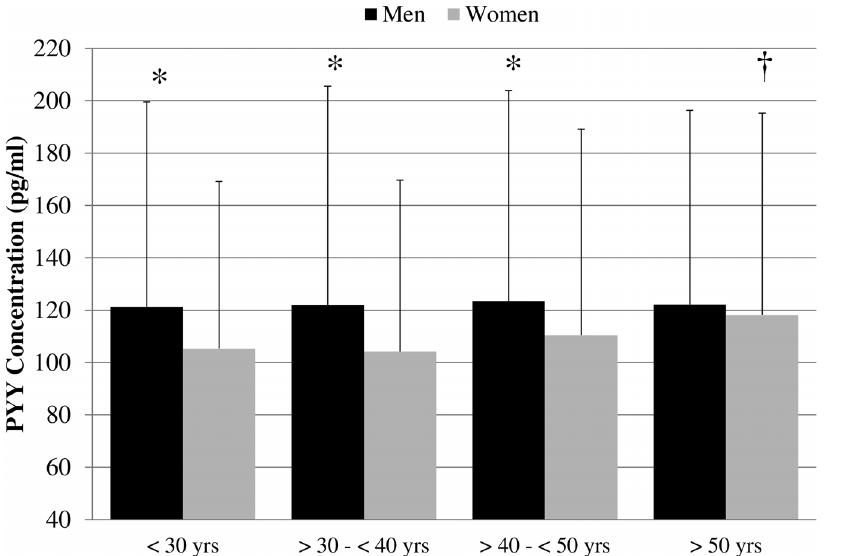
Figure 2. Fasting Serum PYY for men and women in four age groups. Fasting PYY concentration was 15.2%, 17.1% and 11.8% greater among men than women within the , 30 yrs, . 30– , 40 yrs, and . 40– , 50 yrs groups respectively (*). Additionally, the $ 50 yrs group of women had a 12.2% higher circulating level of PYY than women in the , 30 yrs group ( { ). doi:10.1371/journal.pone.0095235.g002 PLOS ONE |